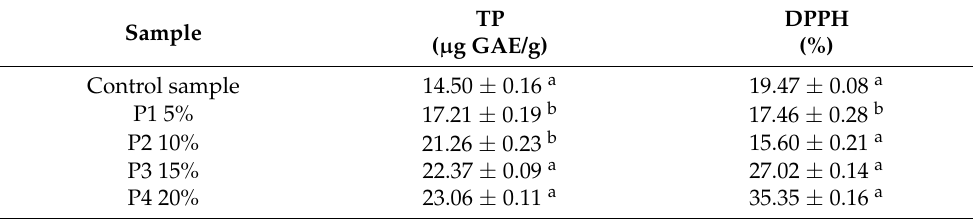
Table 6. Antioxidant activity of spent grain